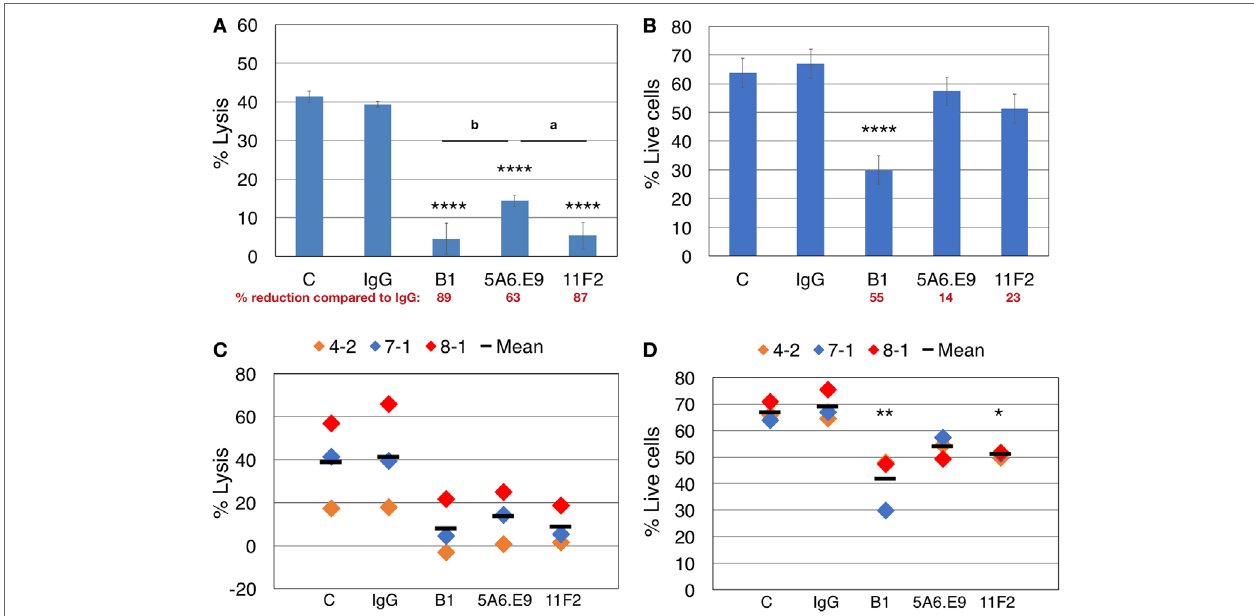
FigUre 4 | Effector blocking alone and blocking cytotoxicity assays should be performed in parallel to account for apoptosis induced by anti- γδ TCR antibodies. (a) Donor 7 day 19 primary human γδ T cells were preincubated for 30 min with the indicated antibodies (1 μ g/well) and then incubated with calcein AM-labeled targets in triplicate at a 20:1 effector:target (E:T) ratio for 4 h. (B) 600,000 Donor 7 day 19 γδ T cells were stimulated with 1 μ g of the indicated antibodies for 4.5 h and labeled with Zombie Aqua viability dye and annexin V (AnnV) FITC; shown are the % live cells that excluded the uptake of dye and were negative for AnnV. (c) Compiled blocking and cytotoxicity results of three independent experiments. (D) Compiled blocking and viability results of three independent experiments. Panels (a,B) were done in parallel, as were experiments shown in panels (c,D) . A significant reduction in % lysis (a,c) or % live cells (B,D) was determined by one-way ANOVA followed by Bonferroni’s pairwise multiple comparison post hoc analysis [* P < 0.05, ** P < 0.01, **** P < 0.0001 versus IgG; among antibody treatments (as indicated): a P < 0.05; b P < 0.01]. Percent reduction compared to IgG (in red font) was calculated: 100 − (% lysis or live cells treated with antibody/IgG ×